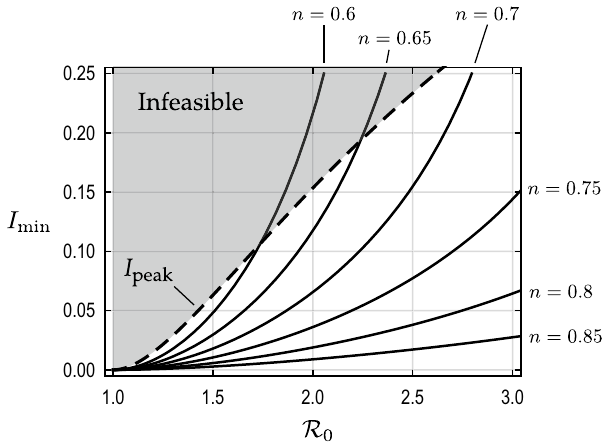
Figure 2. Minimum level of the control threshold to acquire herd immunity with varying shares of the active group in the whole population, n = 1 / N ∈ ( 0, 1 ] . For each n , the condition (6) is satisfied if I c ≥ I min . The proposed strategy with any control threshold, I c , that is above the black solid curve can achieve herd immunity as the whole population. The dashed curve indicates the peak number of infectious individuals I peak , which is an increasing function of R 0 , in the uncontrolled scenario. The assumed control scheme is feasible (in terms of the condition (6) if ) I min ≤ I peak .